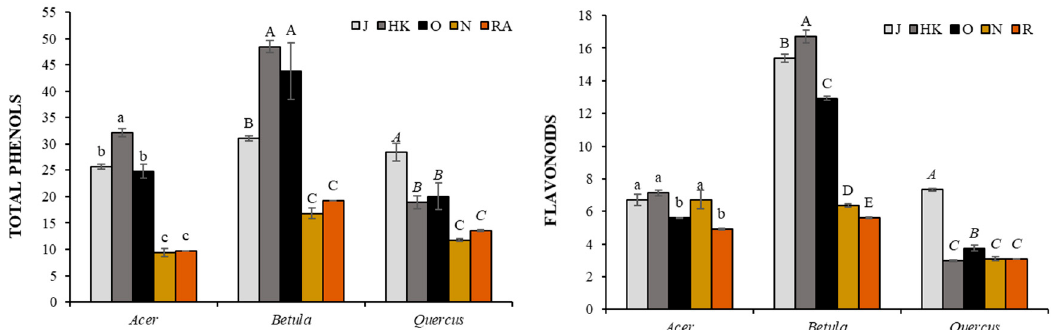
Figure 3. The content of total phenols (mg g − 1 FW) and flavonoids (mg g − 1 FW) in spring bud extracts of Acer pseudoplatanus , Betula pendula , and Quercur robur . J, Ji č ín; HK, Hradec Králové; O, Opatovice n. Labem; N, Nad ě je; RA, Rabštejnská Apatyka. Data are as mean ± SDs ( n = 6). Values within column followed by the same letter(s), are not significantly different according to Tukey’s test ( p < 0.05). The same type of letters shows a significant difference between the values of individual tree.